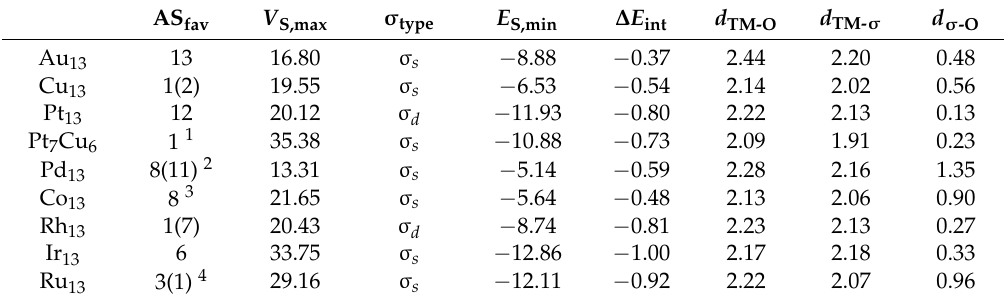
Table 2. H 2 O adsorption position and the corresponding V S,max (kcal/mol) and E S,min (eV) for